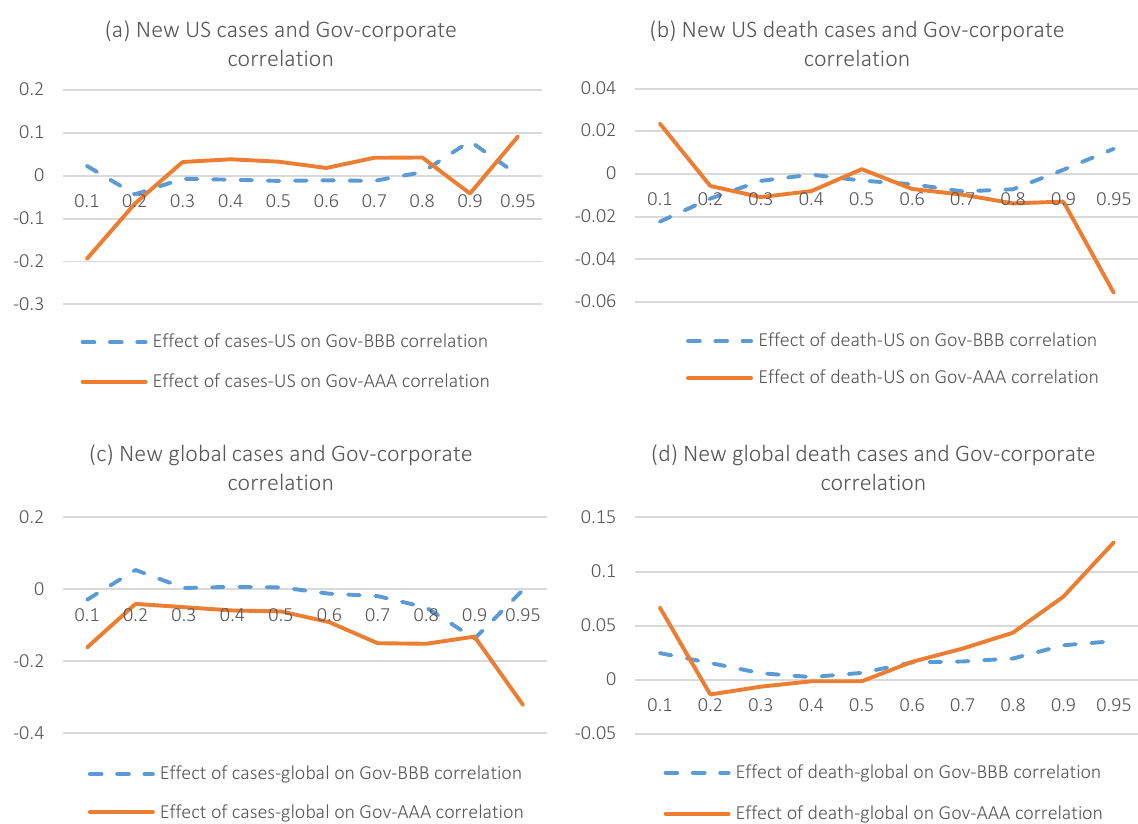
Figure 1. Bond yields, correlations series, and COVID-19